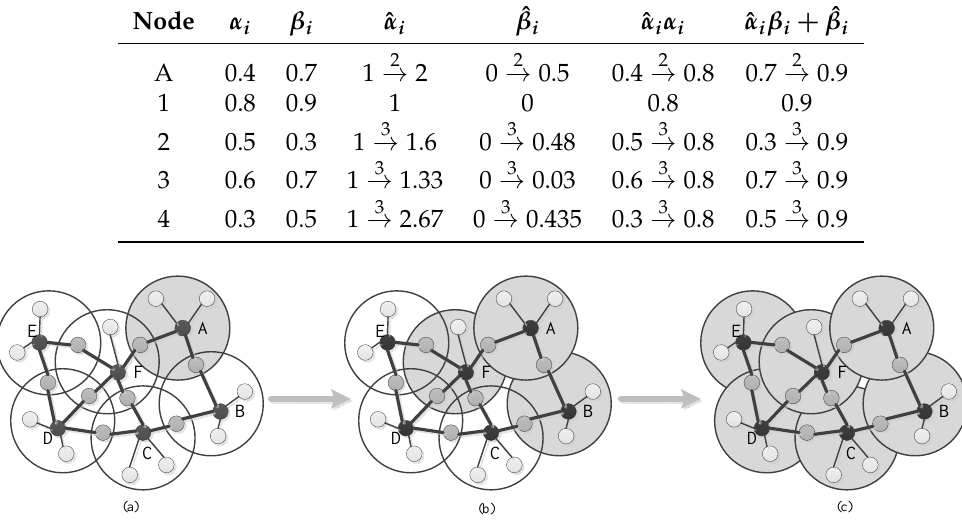
Figure 2. Illustration of inter-cluster time synchronization. ( a ) Time synchronization in cluster A; ( b ) Cluster B and F synchronize with cluster A; ( c ) Cluster C, D, and E synchronize with their adjacent clusters,